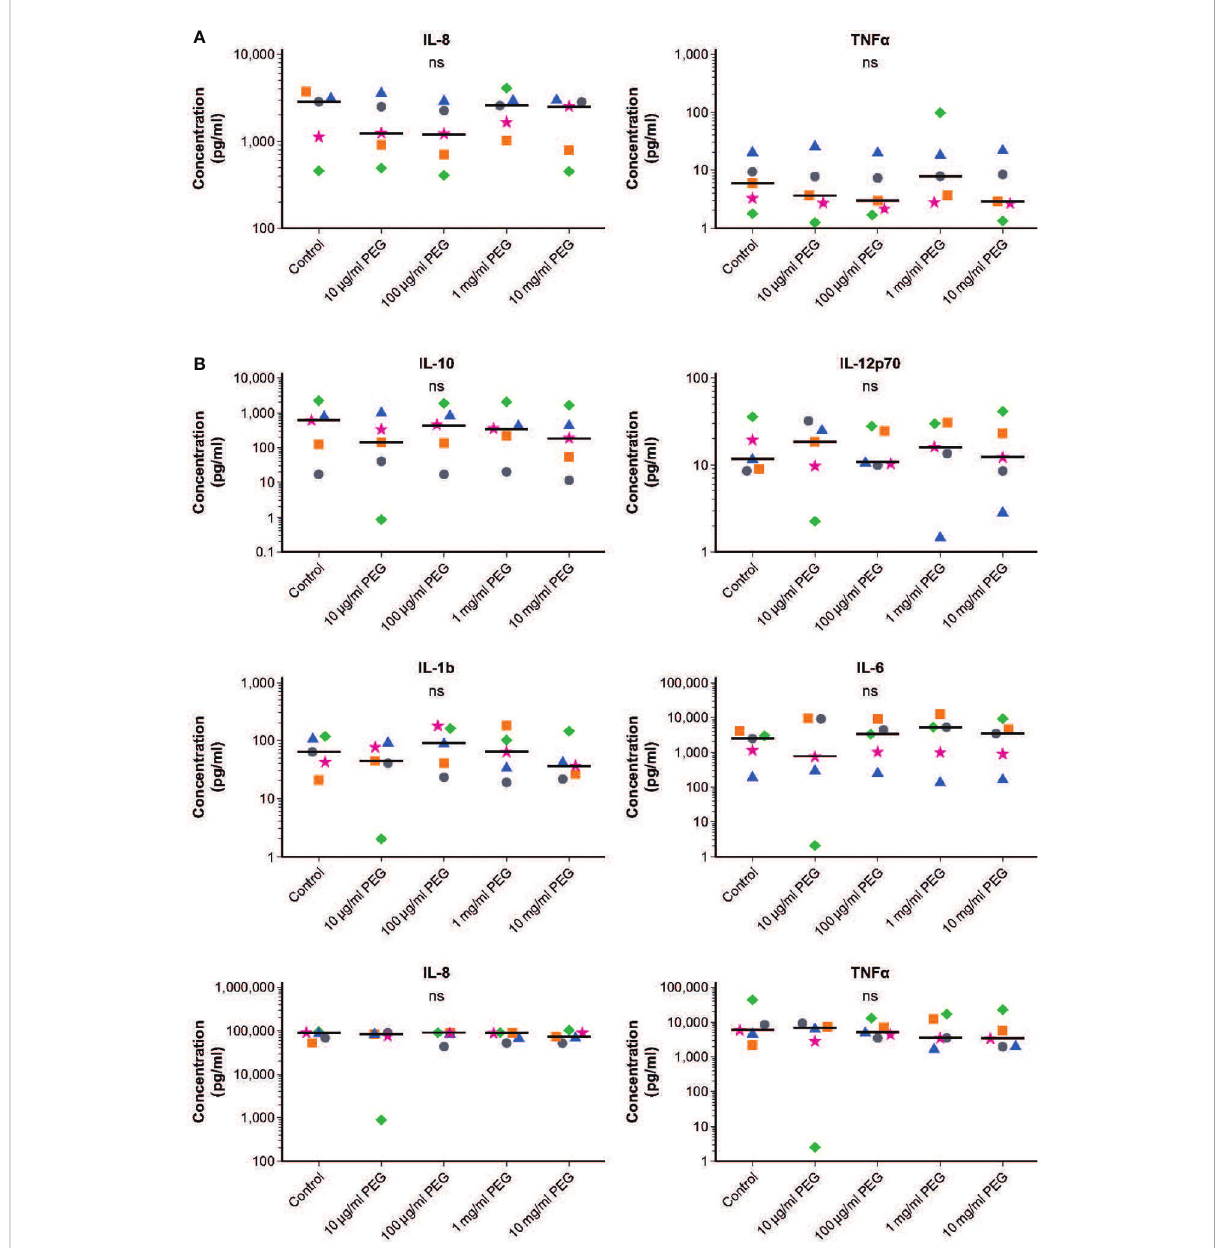
FIGURE 4 Effect of 20-kDa PEG exposure on cytokine secretion by human MDMs. (A) IL-8 and TNF a produced by resting MDMs after 24 hours of PEG exposure (n = 5). Data for not plotted owing to very low expression levels. (B) Cytokines produced by LPS-stimulated MDMs after 24 hours of PEG exposure (n = 5). Data shown as individual values, with the horizontal line indicating the median. ns not signi fi cant (one-way ANOVA/ Friedman ’ s test; post-hoc test: Dunn ’ s multiple comparison). ANOVA, analysis of variance; IL, interleukin; LPS, lipopolysaccharide; MDM, monocyte-derived macrophage; PEG, polyethylene glycol; TNF a , tumor necrosis factor